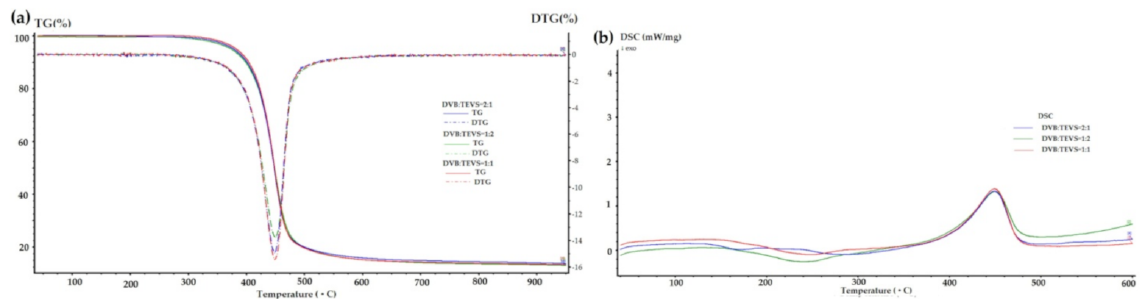
Figure 14. TG, DTG ( a ) and DSC ( b ) curves for DVB-TEVS materials measured in helium conditions after adsorption of NB. Table 6. TG, DTG and DSC data obtained in helium atmosphere for DVB-TEVS materials with loaded P, 4-NP and NB.